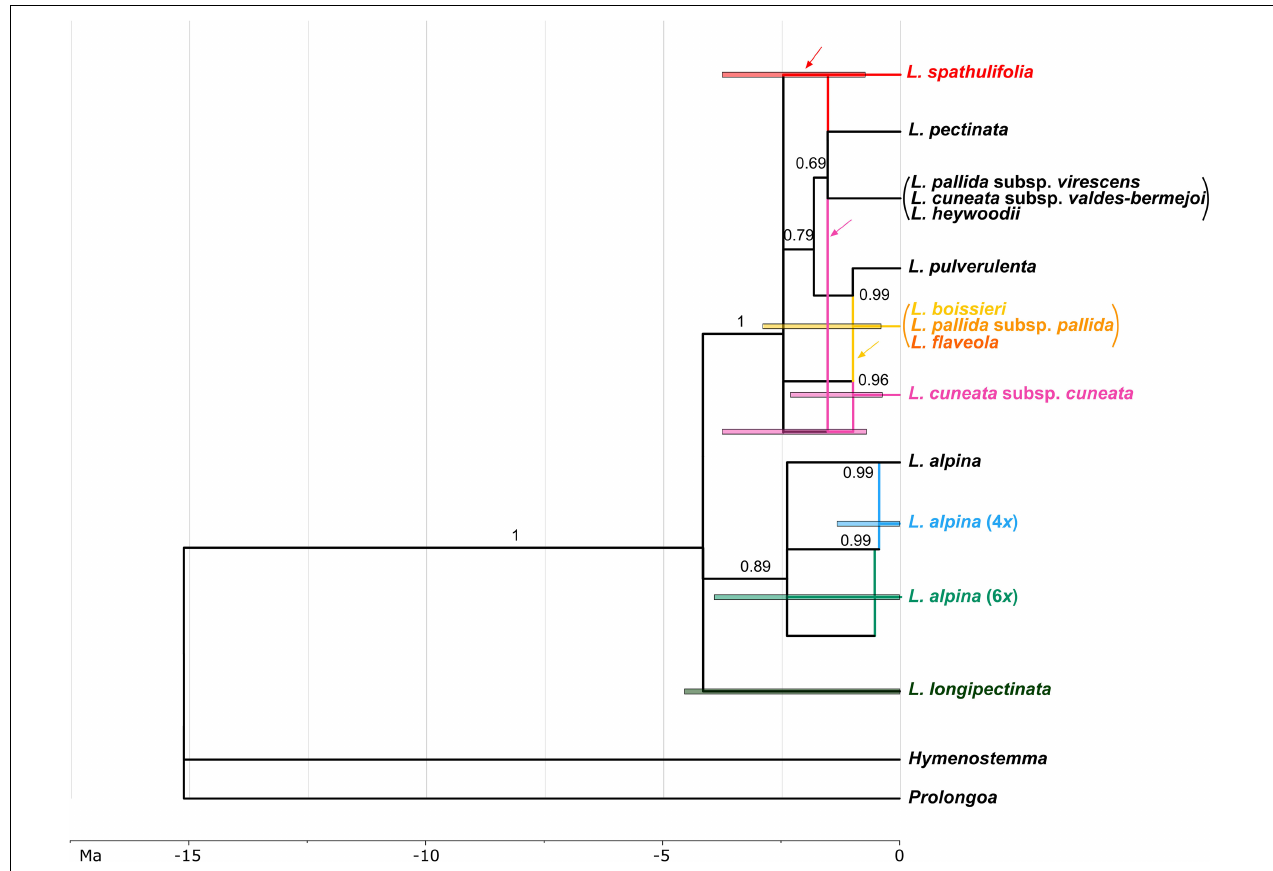
FIGURE 7 | Network representing the phylogenetic relationships and reticulate evolution in Leucanthemopsis . Colors for polyploids correspond to those in Figure 1 . Taxa merged into lineages by the species delimitation analyses are within parentheses (the diploids L. cuneata subsp. valdes-bermejoi , L. heywoodii , and L. pallida subsp. virescens, and the tetraploid L. boissieri , L. flaveola , and L. pallida subsp. pallida , respectively). The numbers above branches are posterior probabilities obtained in the *B EAST analysis. Branches that had posterior probability below 0.69 in the multi-labeled species tree ( Supplementary Figure 1 ) were collapsed in the species network. Edges representing the maternal progenitor of a polyploid as inferred in A LL C O P OL are indicated by arrows. Colored bars indicate 95% highest posterior density (HPD) intervals of the age estimates. For polyploids, 95% HPD of age estimates were obtained merging the 95% HPD of the divergence times